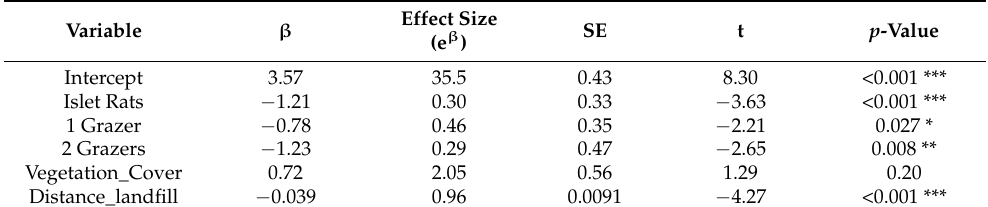
with a p -value less than 0.001.